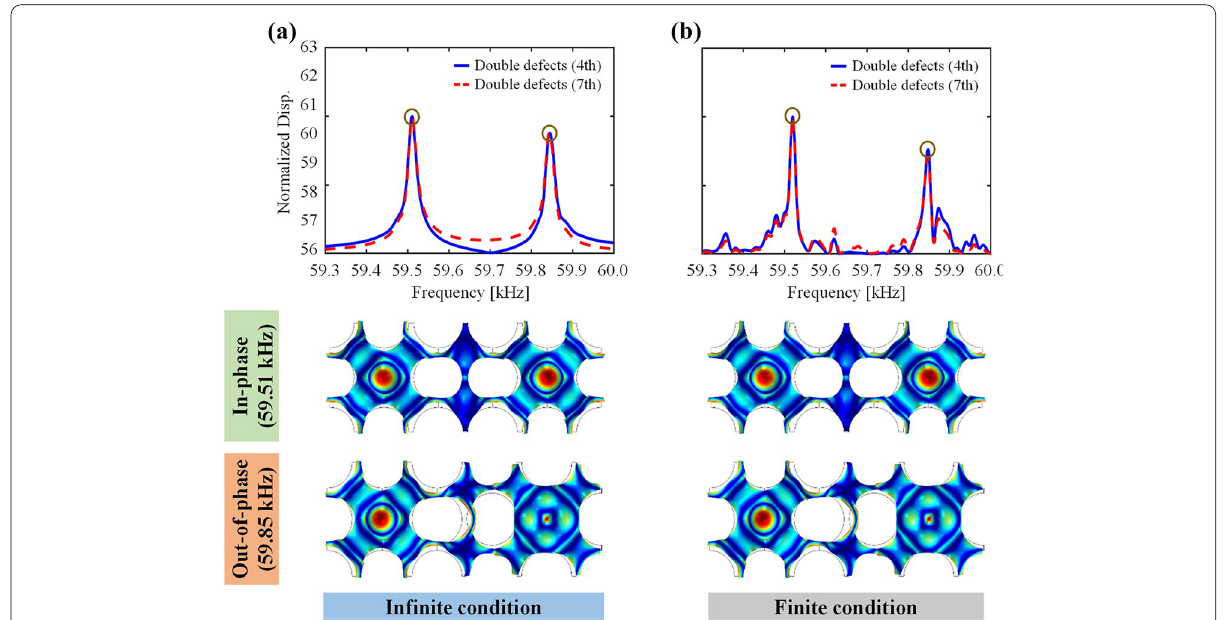
Fig. 5 Comparison of numerical simulation results under the a infinite and b finite domain conditions: normalized out‑of‑plane displacement frequency response functions (top) and the x 3 ‑directional operating deflection shapes (bottom) inside the double defects (4, 7) in the phononic crystal at the peak frequencies of 59.51 and 59.85 kHz